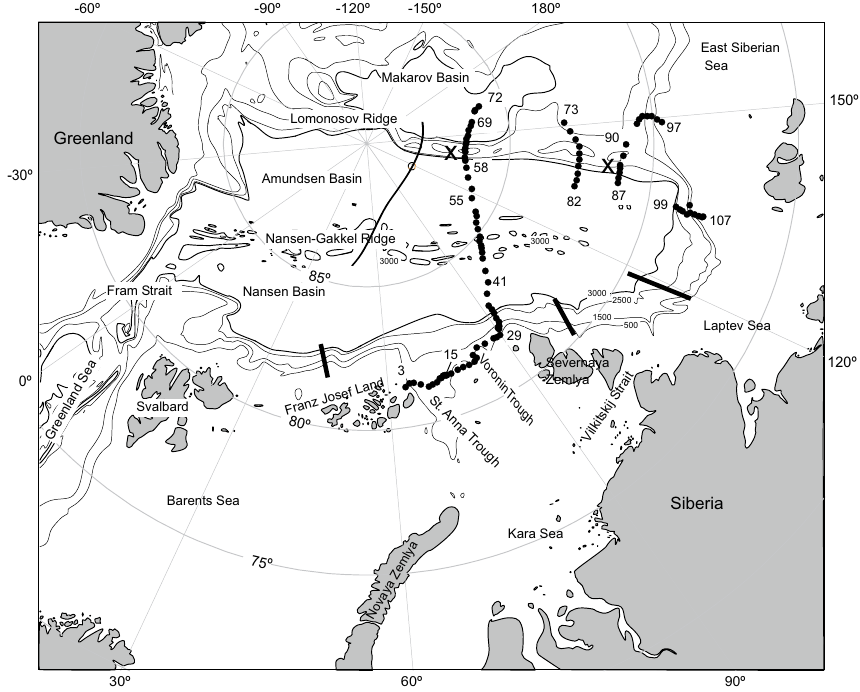
Fig. 1. Locations of Polarstern ARKXII stations in the Arctic Ocean (dots with station numbers). Crosses de- note the position of elevations of the Lomonosov Ridge of less than 1000m water depth according to the Interna- tional Bathymetric Chart of the Arc- tic Ocean (IBCAO) (2000). The thin line in the Amundsen Basin marks a section occupied in 1991 by Oden, which is used in Fig. 15. The thick lines along the Nansen Basin continen- tal slope mark sections from Polarstern cruises ARKIX-4 1993 (at 40 ◦ E and 125 ◦ E), from ARKXII 1996 (at 95 ◦ E) and from ARKXI-1 1995 (at 105 ◦ E) used in Fig.